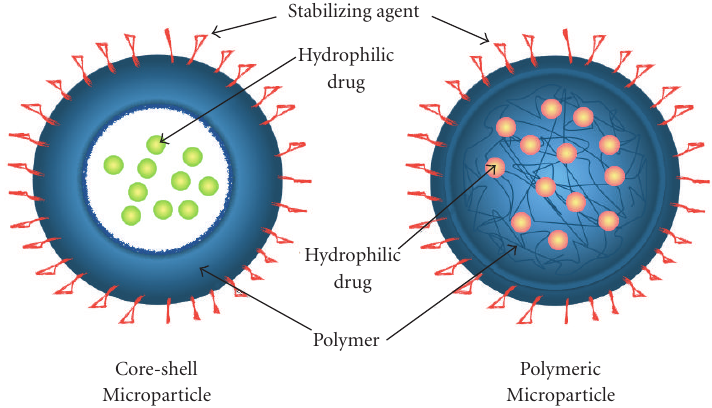
Figure 2: Scheme of the morphology of polymeric microparticles prepared by the single- and double-emulsion method and their internal distribution of drugs with di ff erent physicochemical